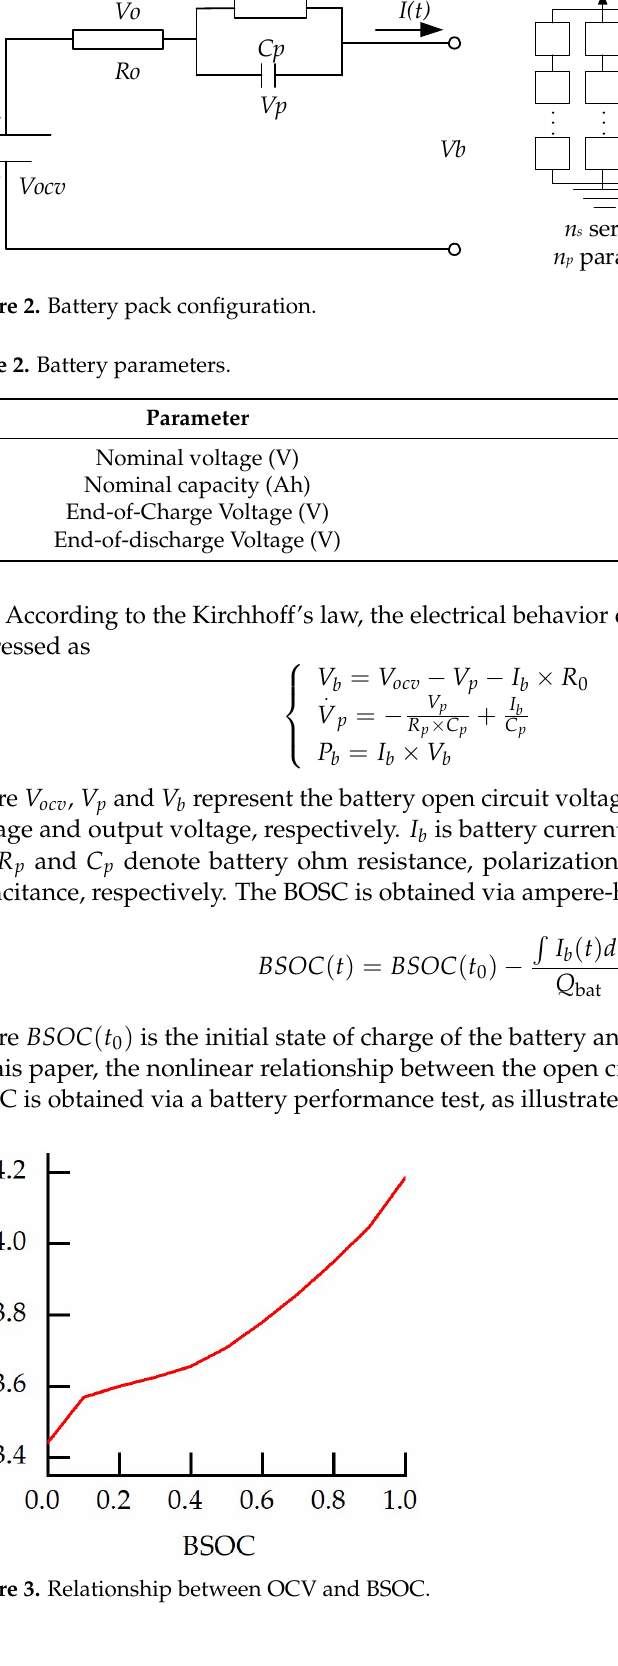
( d ) Figure 4. Charging and discharging characteristic curves of ( a ) total internal resistance, ( b ) ohmic internal resistance, ( c ) polarization internal resistance and ( d ) polarization capacitance.